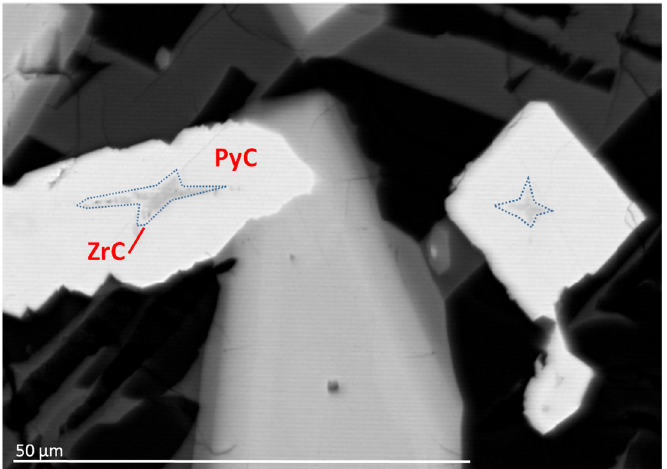
Figure 9. BSE(Z) micrograph of pyrochlore grains in ASSB-7 with zirconate lamellae in the